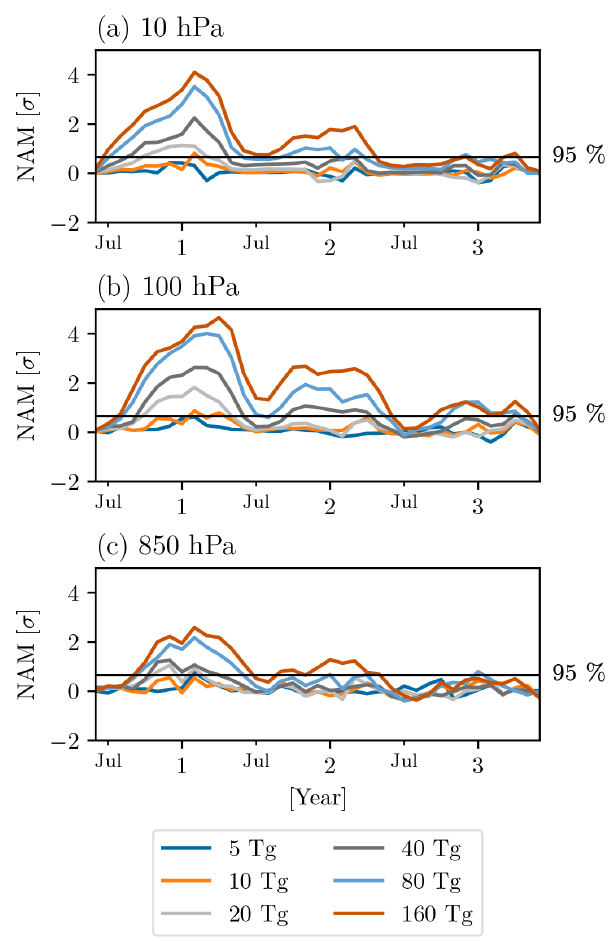
Figure 4. Monthly evolution of the NAM response for 3 years af- ter the June eruptions, with the 95% confidence significance level indicated by the black horizontal line, at (a) 10hPa, (b) 100hPa, and (c) 850hPa. The units on the ordinate are standard deviations of the NAM from the PI control ( σ ). On the abscissa, the numbers 1, 2, and 3 designate the first, second, and third January after the